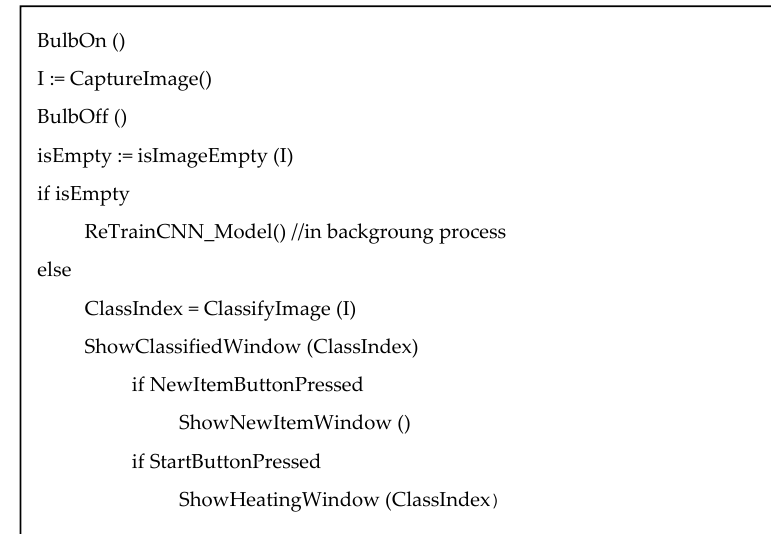
Figure 6. Pseudocode of the callback function for the door closed event.